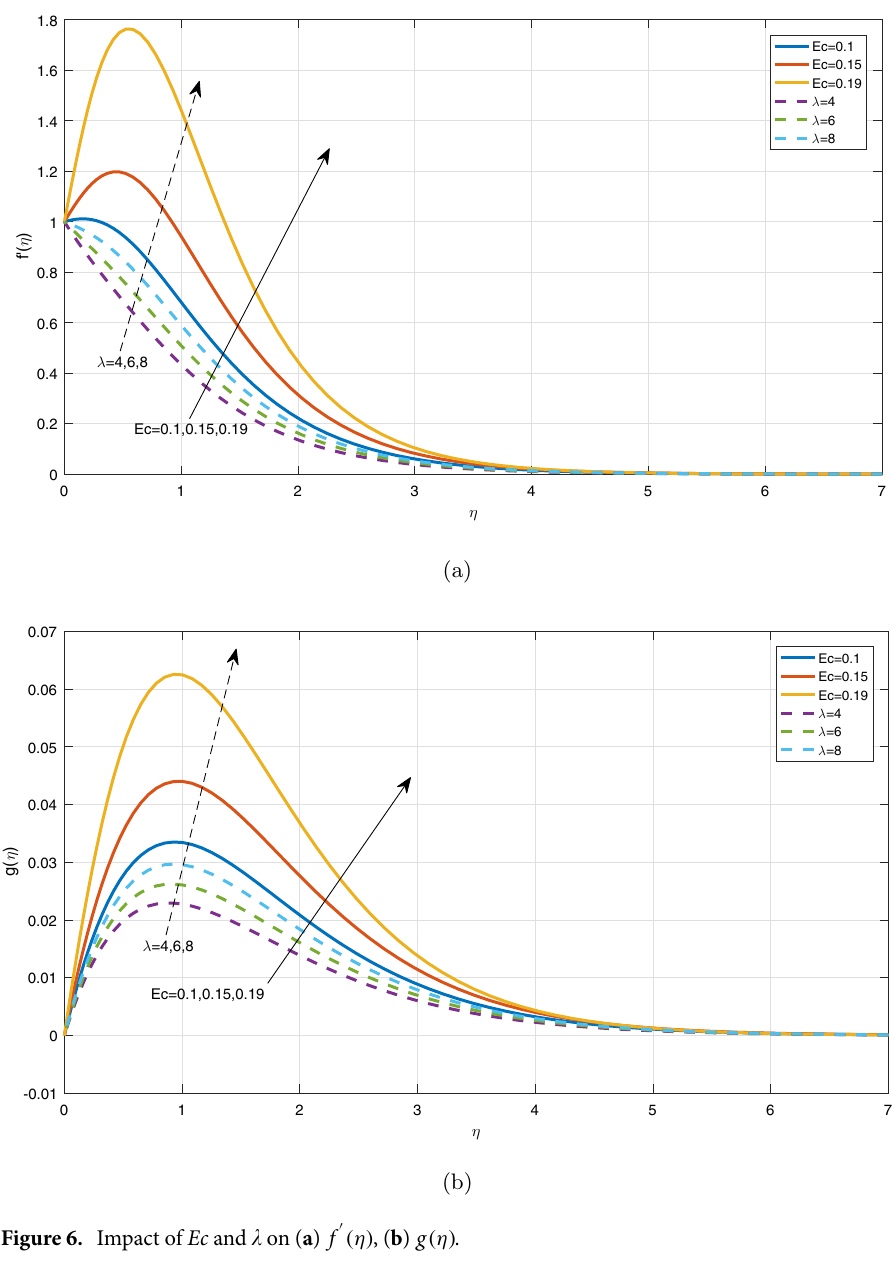
Figure 6. Impact of Ec and (cid:31) on ( a ) f ′ (η) , ( b ) g (η)